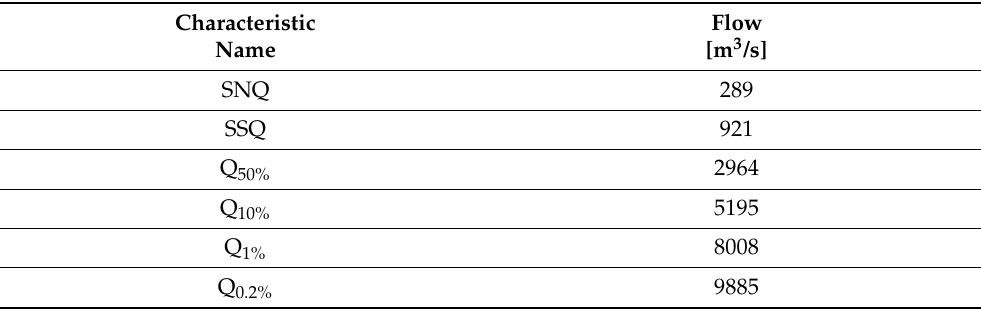
Table 3. Flow characteristics at the Włocławek water gauge (SNQ—average from the lowest an- nual flows, SSQ—average from annual averages, Q 50% —maximum once every two years, Q 10%